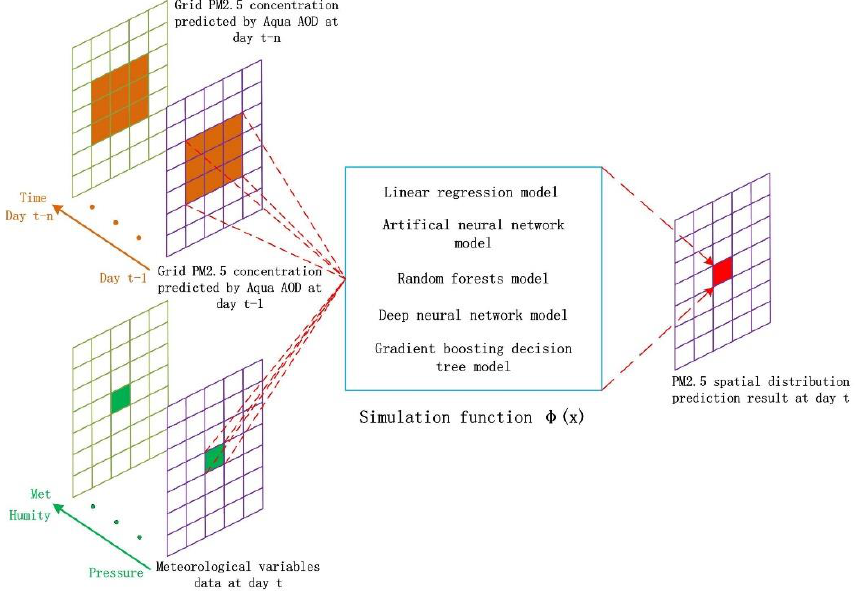
Figure 2 . Schematic of the STAR model considering the influence of meteorological factors.